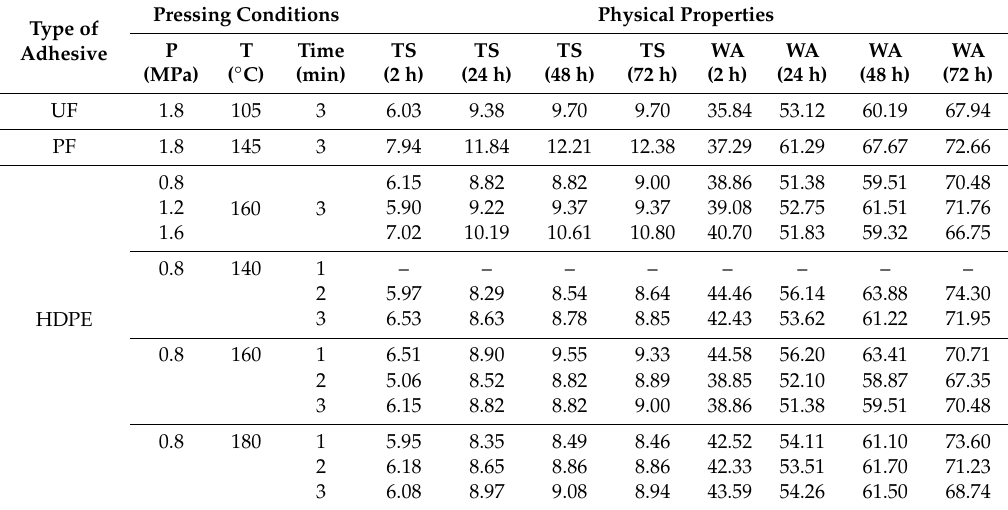
Table 7. Thickness swelling (TS) and water absorption (WA) of plywood panels pressed using di ff erent types of adhesive and pressing conditions.